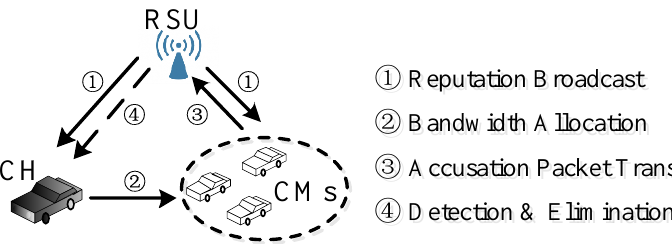
Figure 4. The reputation-based incentive and penalty